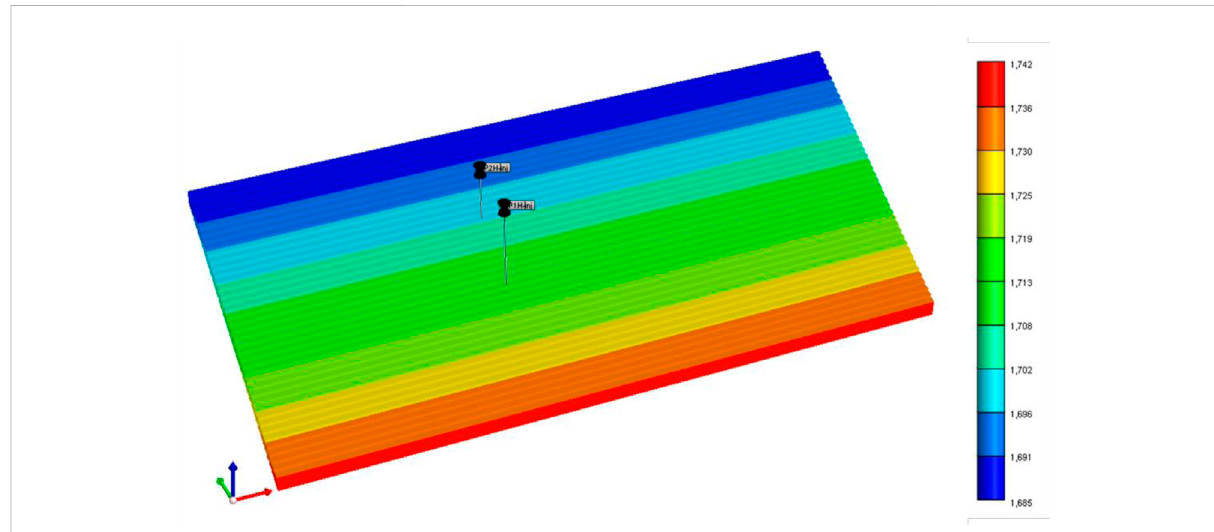
FIGURE 4 Numerical model used for the well-to-well interplay during CO2 huff-n-puff (grid top).